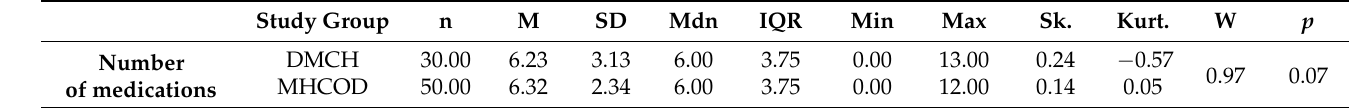
Table 5. Number of medications taken by patients in both